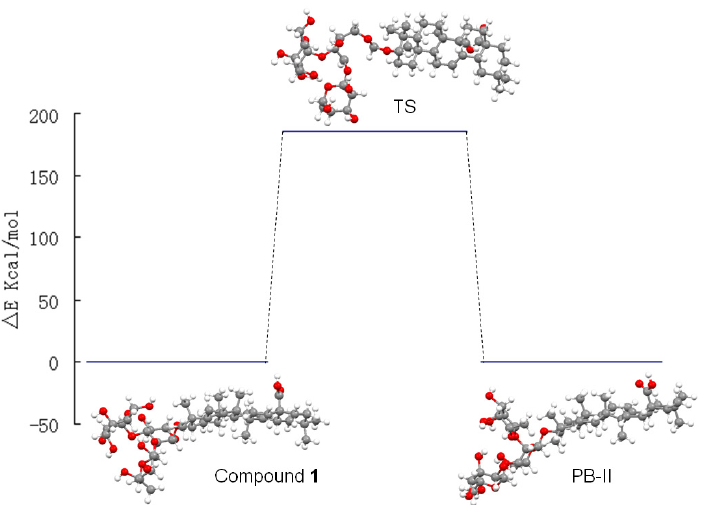
Figure 2. The energy gap between different